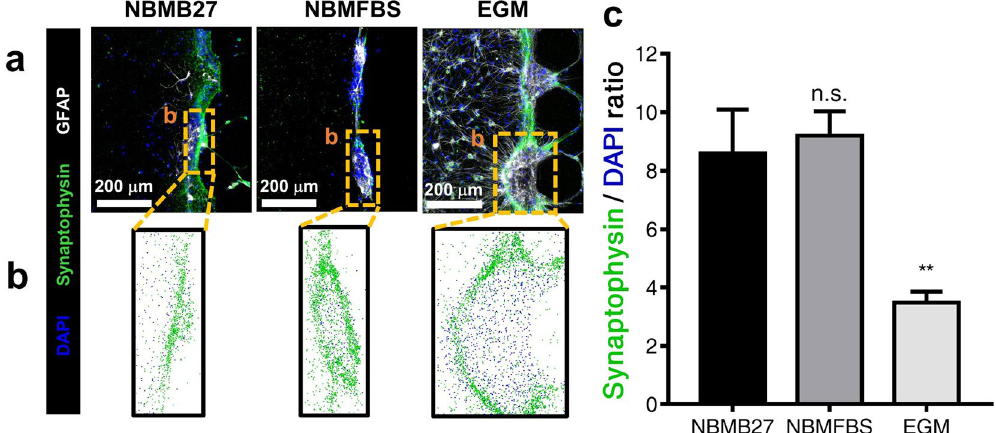
Figure 2. Comparison of three neuron cultures in NBMB27, NBMFBS, and EGM for assessing the effect of FBS in neural cultures. ( a ) Immunostained images of each experimental medium culture. ( b ) The total number of nuclei and synapses identified in each culture. As the neurons were grown in a mass against the fibrin hydrogel wall and do not migrate, synaptic connections were measured at the cell mass. ( c ) The per neuron average of synaptic connections value for NBMFBS was found to be similar to that of cultures grown in NBMB27 control. EGM supplied neuronal cultures show a drastic decrease in synaptic connectivity. All data show mean ± SEM. Statistical analysis student’s t-test. ** p < 0.01. 12 ROI for each condition were used for